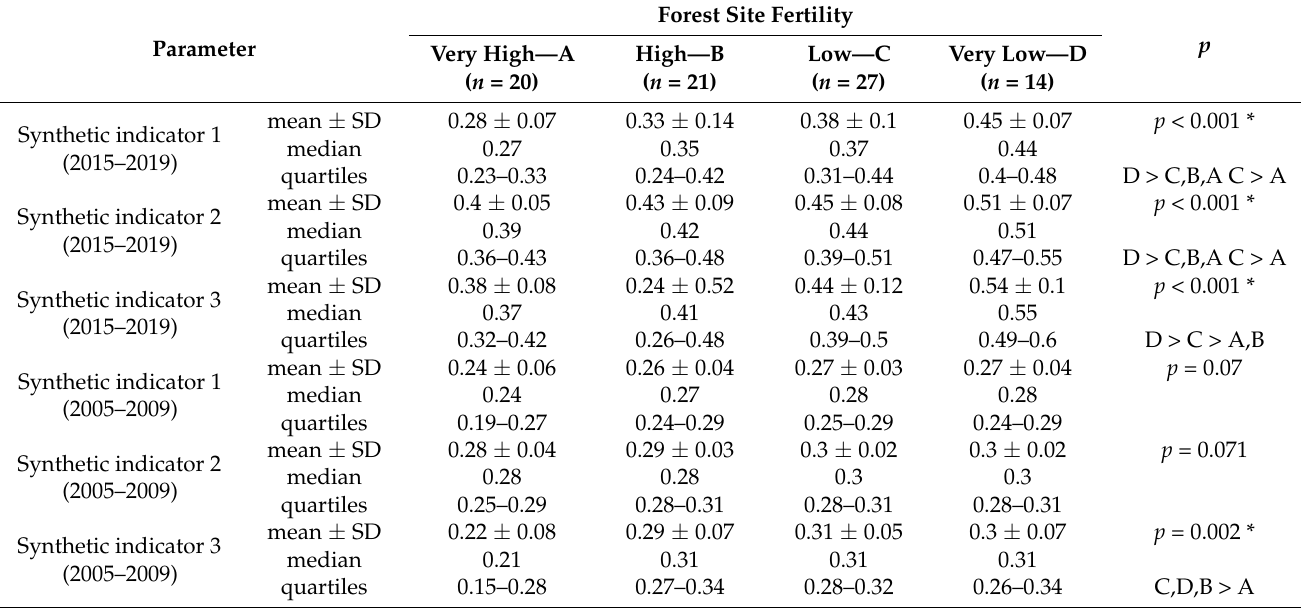
Table 4. Relationships between the synthetic indicators and forest district categories distinguished on the basis of site fertility.